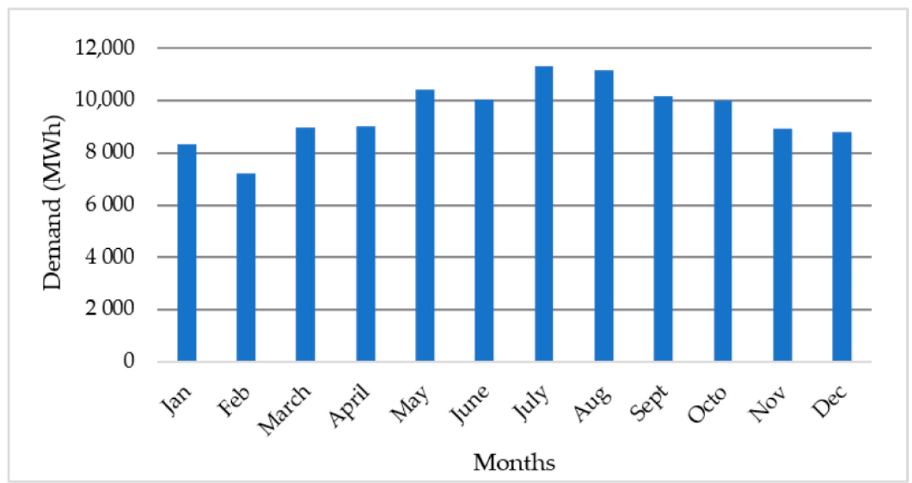
Figure 11. Total electricity demand on Isla de la Juventud in different month of 2019 Source: own elaboration with the model [27].